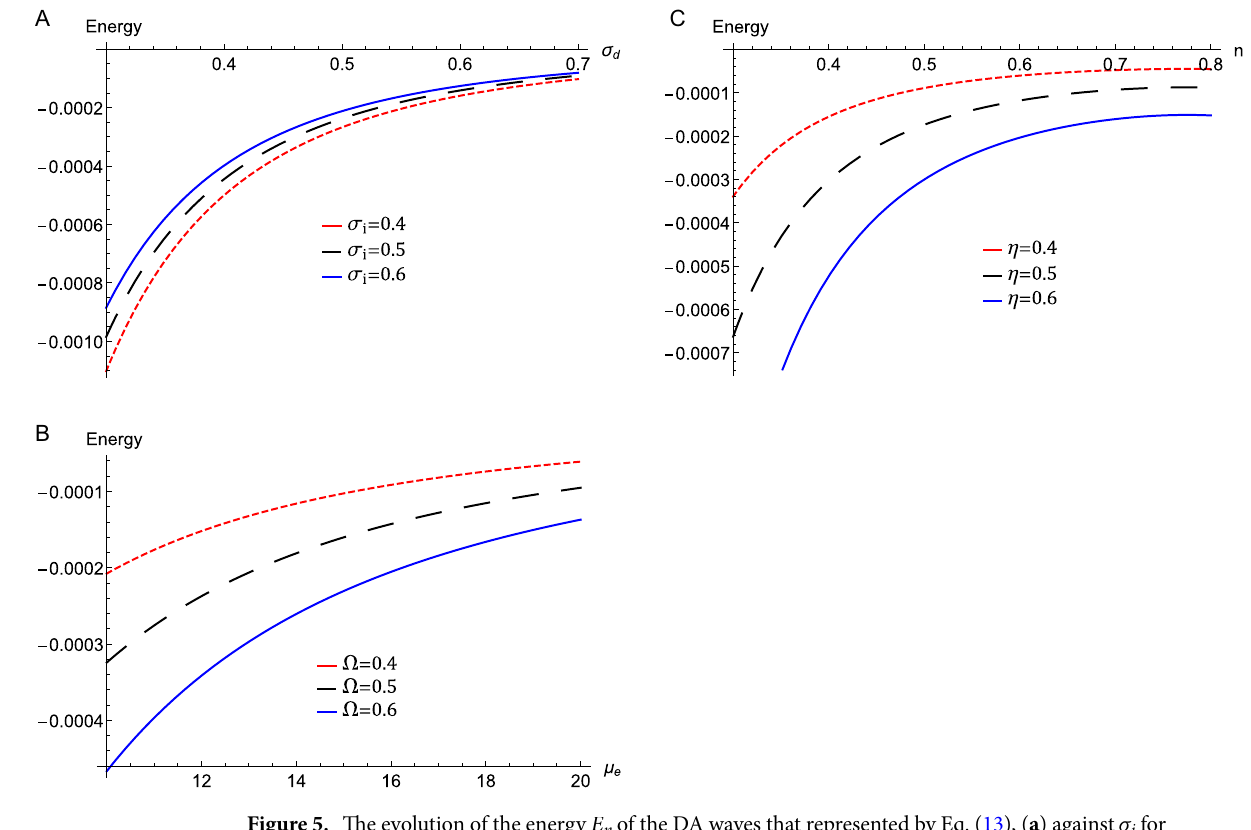
Figure 5. The evolution of the energy E n of the DA waves that represented by Eq. (13), ( a ) against σ i for different values of σ d with η = 0.8 , n = 0.4 , (cid:31) = 0.5 , and µ e = 12 , ( b ) against µ e for different values of (cid:31) with η = 0.8 , n = 0.4 , σ i = 0.5 and σ d = 0.5 , ( c ) against n for different values of η with σ i = 0.5 , σ d = 0.5 , (cid:31) = 0.5 , and µ e = 18